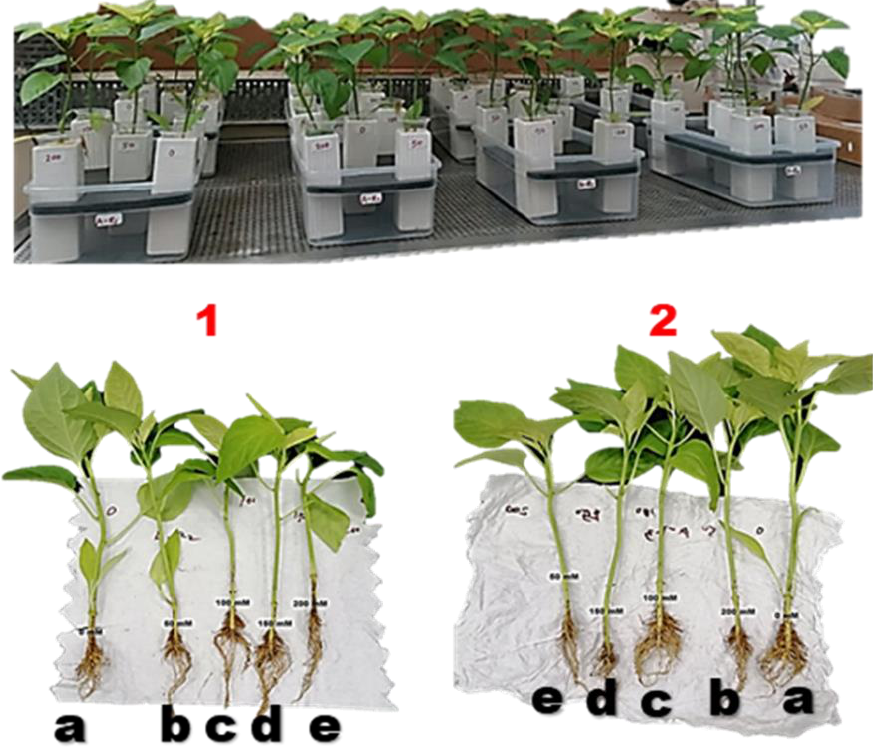
Figure 5. The experimental design and morphological variation of induced NaCl bell pepper plants 1 . Water sprayed, and 2 . Roholtiella sp. extract sprayed induced plants after 10 days a: 0 Mm induced plant, b: 50 mM NaCl-induced plants, c: 100 mM NaCl-induced plants, d: 150 mM NaCl-induced plants, and e: 200 mM NaCl-induced plants.